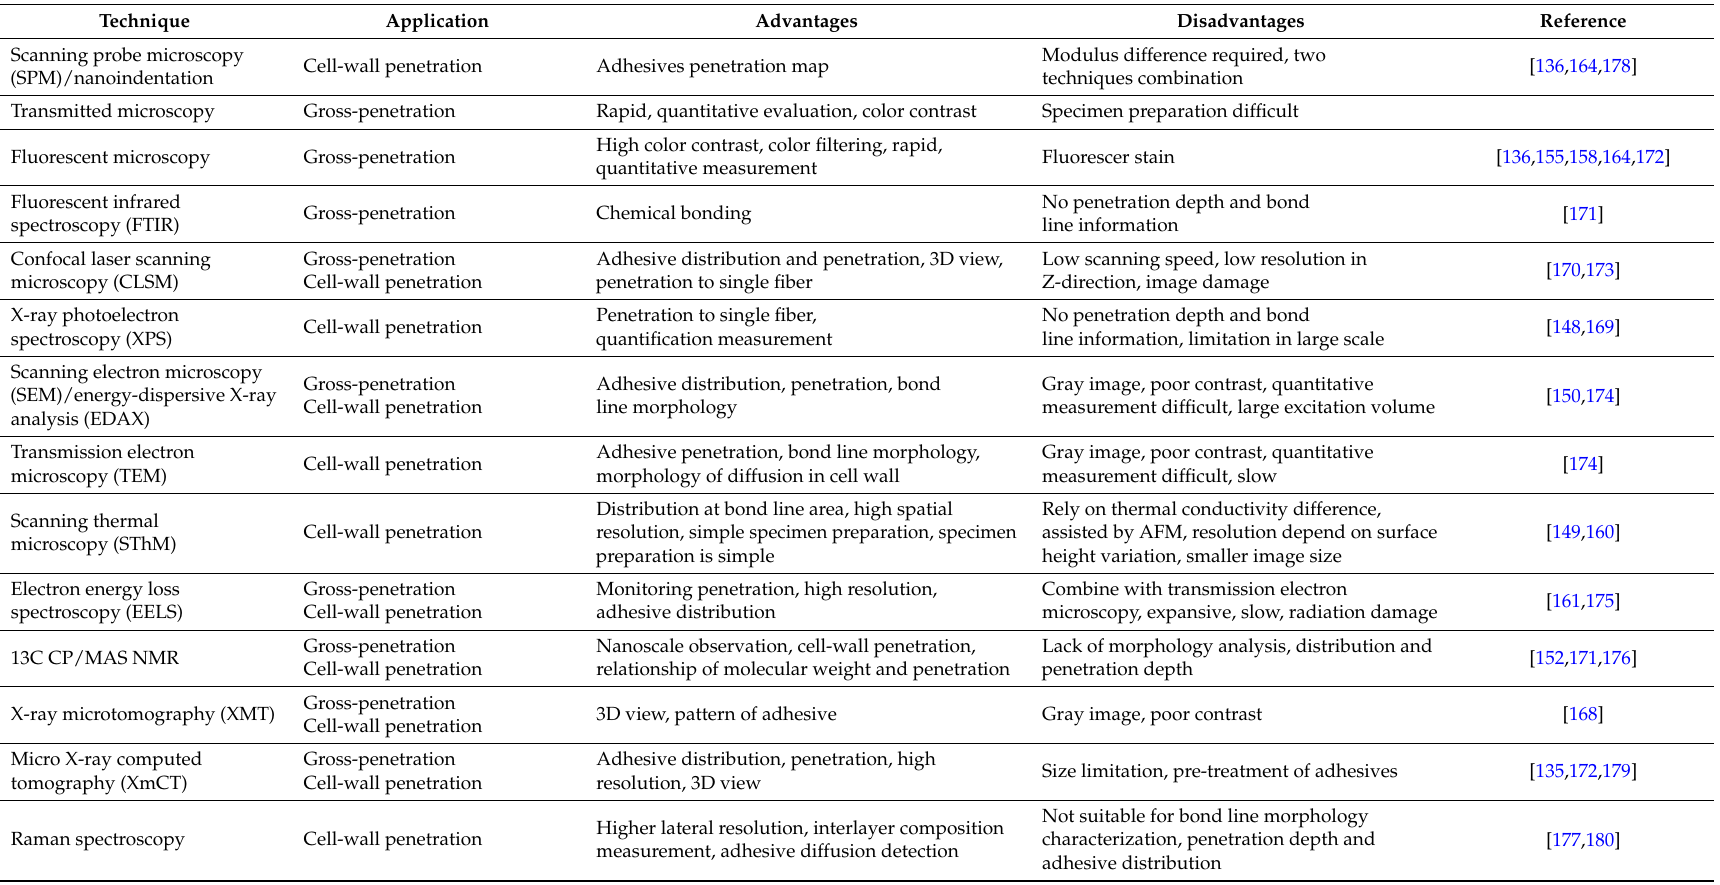
Table 2. The comparison of common techniques used in adhesive penetration